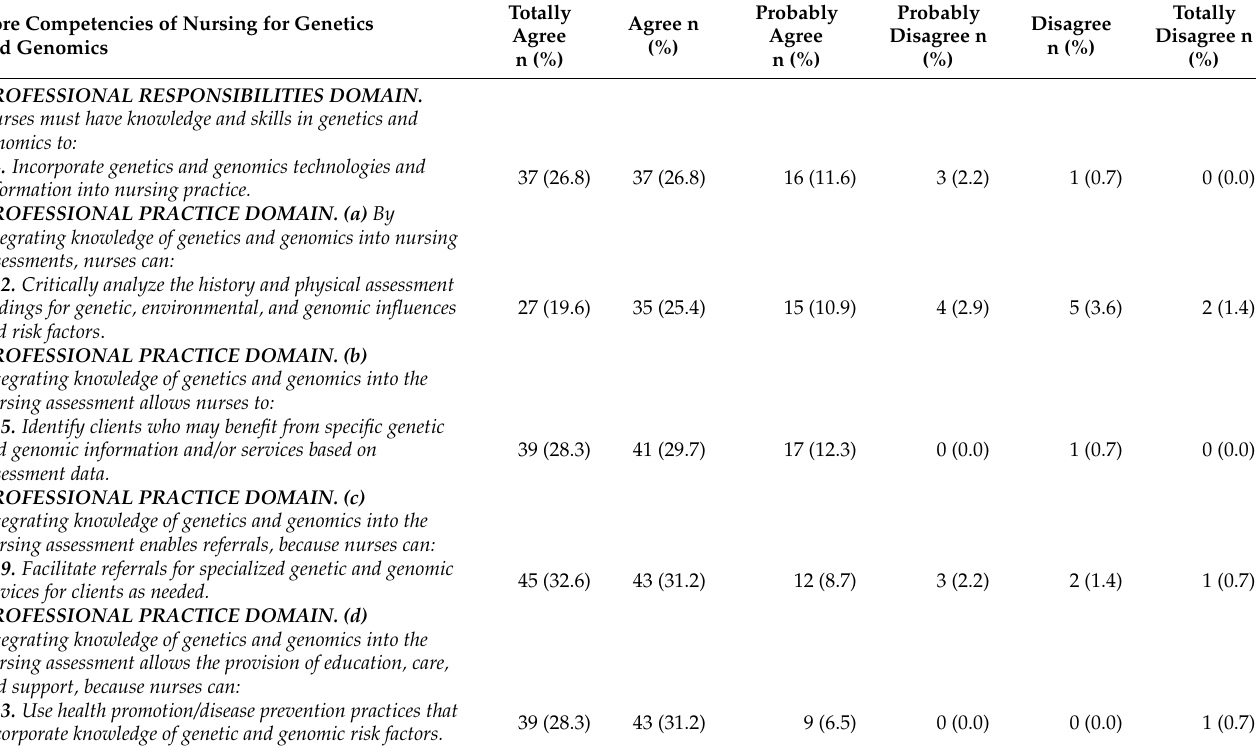
Table 2. Perceptions of undergraduate nursing program coordinators about the “Essential Nursing Competencies and Curricula Guidelines for Genetics and Genomics”.